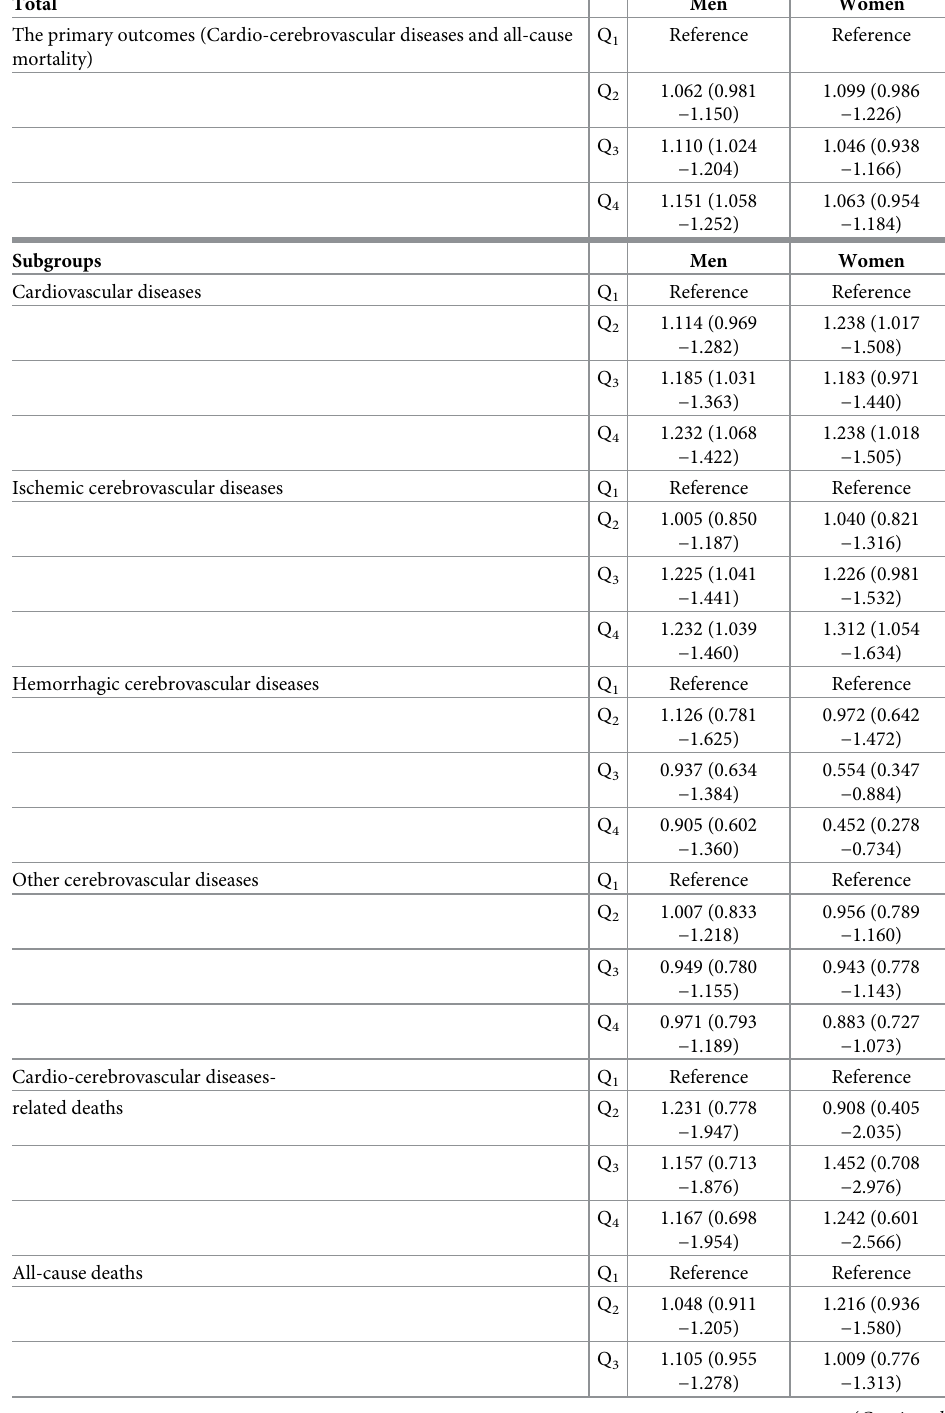
Table 2. Cox-proportional hazards regression model for cardiovascular diseases, cerebrovascular diseases, car- dio-cerebrovascular diseases, cardio-cerebrovascular diseases-related death, or all-cause death according to